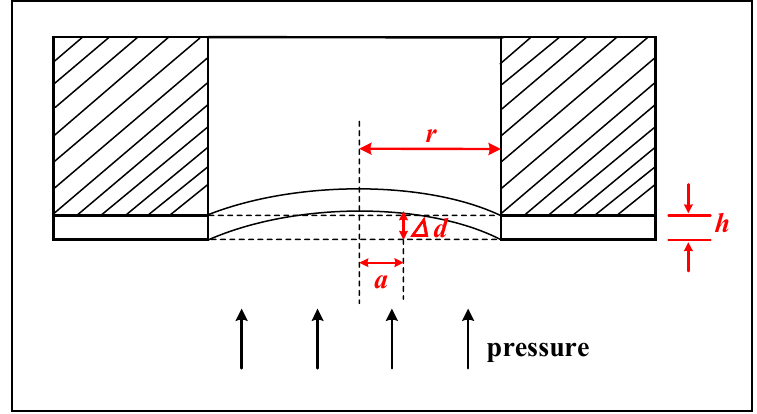
Figure 2. Schematic of membrane deformation under pressure.